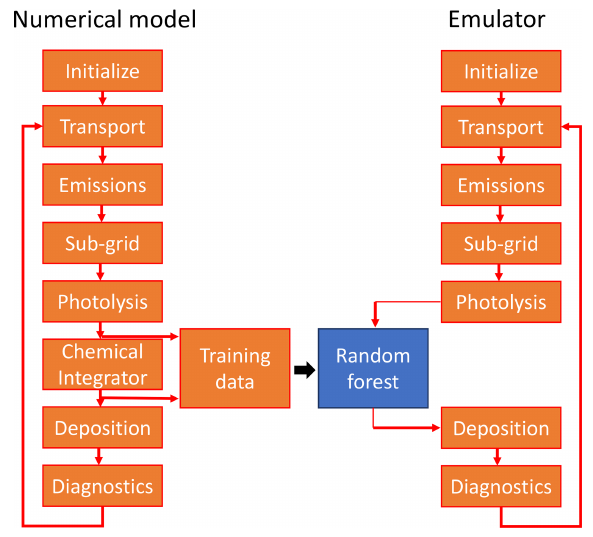
Figure 1. Schematic overview of the use of a random forest regres- sion algorithm as an alternative to the chemistry solver. The origi- nal numerical model (GEOS-Chem) sequentially solves the opera- tions relevant to atmospheric chemistry, with the chemical integra- tor being the computationally most expensive step (left side). Using training data produced from the full model, we generate a machine learning emulator that can then be used instead of the chemical in- tegrator (right side). All other model processes are the same as in the original